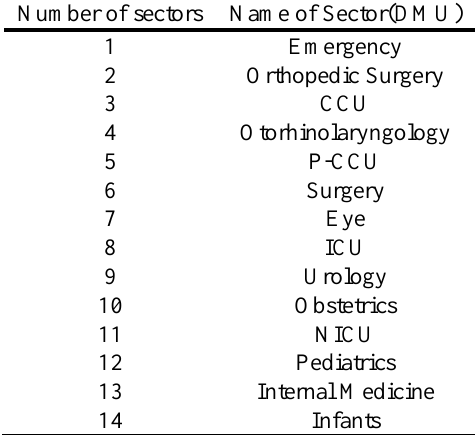
Table 1. Hospital sectors in 2010